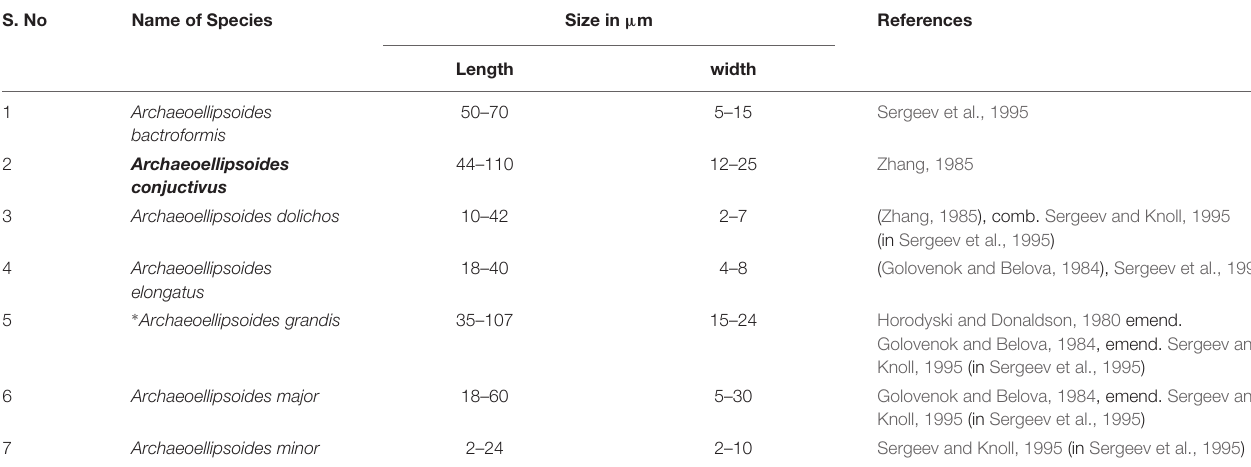
TABLE 1 | A list of recorded akinetes in the present study showing size range from the Salkhan